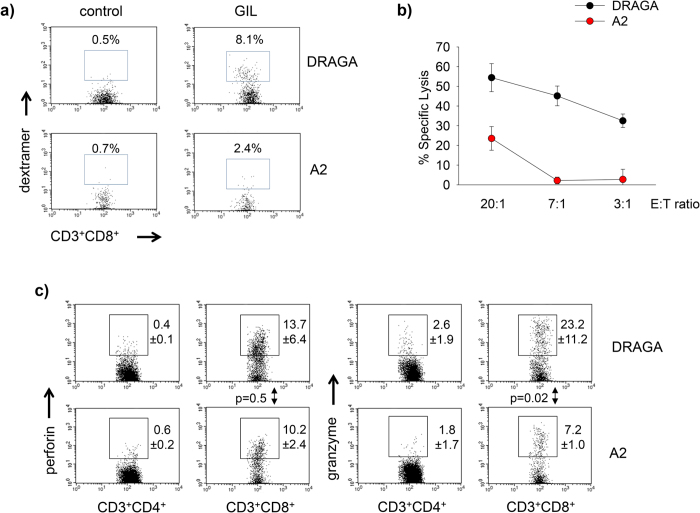
Co-expression of HLA-A2 and HLA-DR4 molecules in NRG mice increases the numbers and function of antigen-specific human CD8 T cells.Panel (a) DRAGA and A2 mice (n = 3 per group, infused with HSC from the same donor) were immunized intramuscularly twice at two weeks apart with GIL peptide (200 μg) encapsulated in liposomes (100 μl). Ten days after the last immunization, pooled splenocytes from the three mice were analyzed by FACS using human CD3, CD8, and HLA-A2/GIL dextramers. Control mice were non-immunized DRAGA and A2 mice (n = 2) that were infused with HSC from the same donor as the GIL-immunized mice. Data show the frequency of GIL-specific CD8 T cells in DRAGA and A2 mice. Panel (b) splenic cells from GIL-immunized DRAGA and A2 mice (n = 3 pooled) were stimulated in vitro with GIL peptide for seven days, and effector cells were incubated at various cell ratios with GIL-pulsed T2 target cells (effector:target, E:T) for 4 hours. Data points represent mean ± SD percent of specific lysis as measured by 51Cr release in triplicated samples. Panel (c), expression of intra-cellular perforin and granzyme B in splenic CD8 T and CD4 T cells from DRAGA (n = 7) and A2 (n = 3) mice. Data represent mean ± SD of mice analyzed individually.